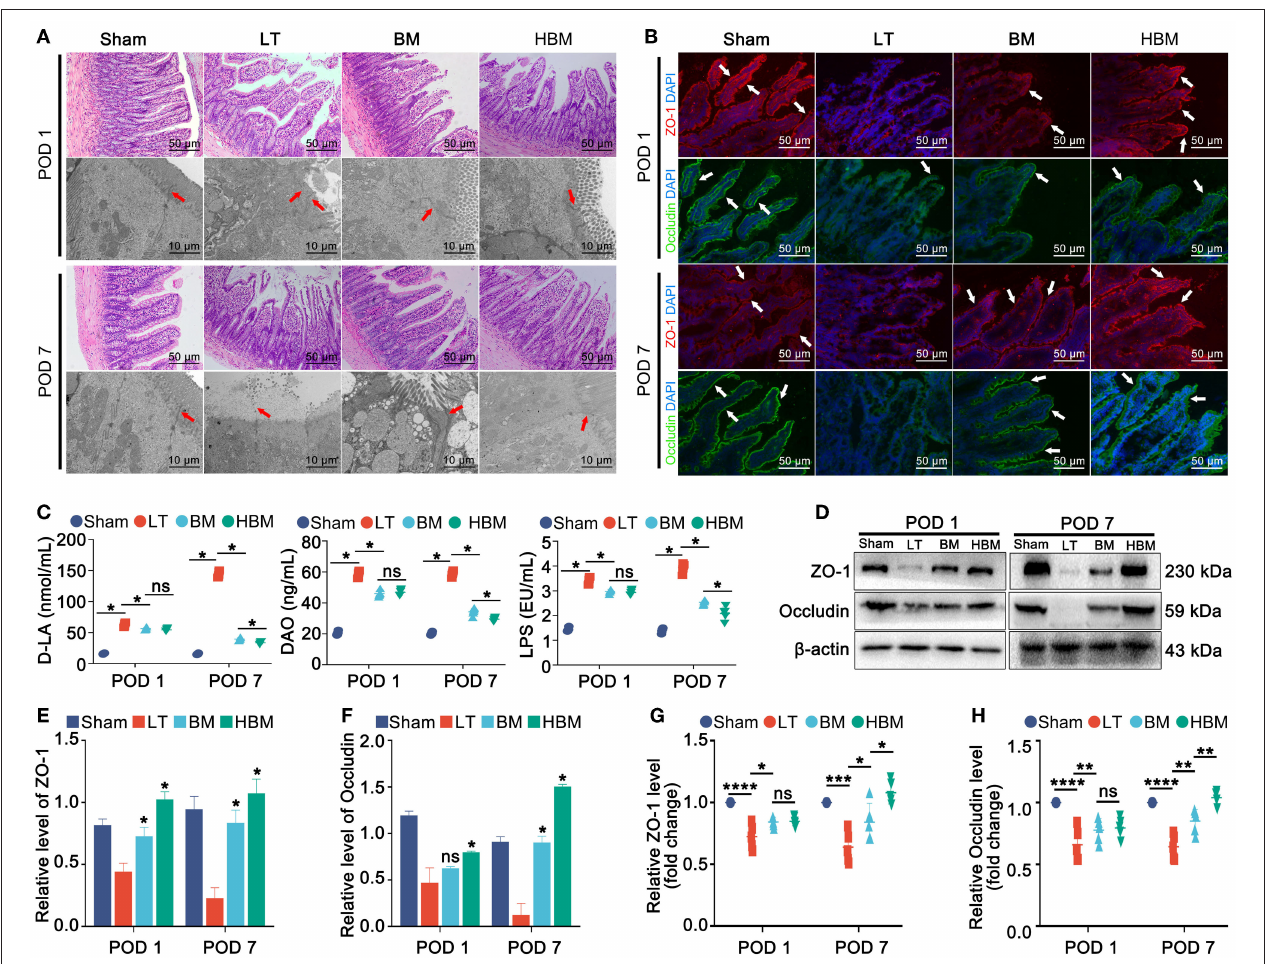
FIGURE 3 | Changes in intestinal histology, ultrastructure, and permeability of the recipients. (A) Histopathology of steatotic donor liver recipient rats at different time points after surgery ( × 200). (B) Immunofluorescence of intestinal tight junction proteins ZO-1 and Occludin (indicated by a white arrow; × 200). (C) Changes in intestinal permeability. On POD 1, plasma D-LA (63.17 ± 3.74 nmol/mL), DAO (58.56 ± 2.42ng/mL), and LPS (3.42 ± 0.15 EU/mL) in the LT group were significantly increased ( P < 0.05); on POD 7, D-LA (144.10 ± 5.42 nmol/mL) and LPS (3.94 ± 0.20 EU/mL) in the LT group continued to increase; while D-LA, DAO, and LPS in the BM group showed a stable trend, but decreased in the HBM group ( P < 0.05). (D–H ) Protein and mRNA expression levels of ZO-1 and Occludin. * P < 0.05, ** P < 0.01, *** P < 0.001, **** P <